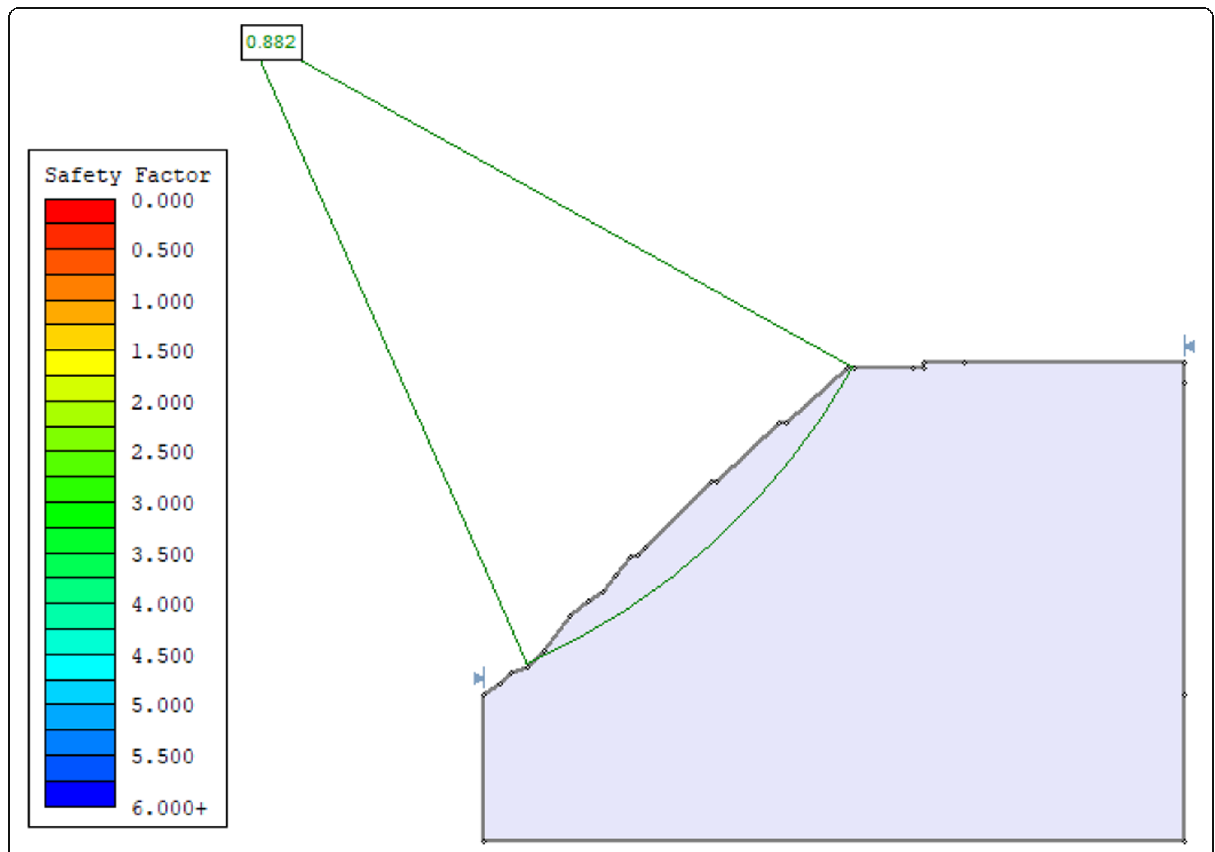
Fig. 12 Slip surface as per Bishops